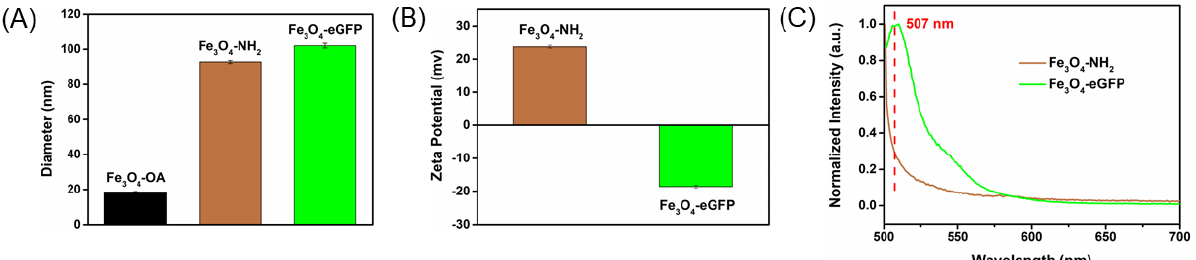
Figure 3. ( A ) Average diameter of Fe 3 O 4 – OA, Fe 3 O 4 – NH 2 , and Fe 3 O 4 – eGFP measured by DLS. ( B ) Zeta potential and ( C ) fluorescence emission spectra of Fe 3 O 4 – NH 2 and Fe 3 O 4 – eGFP.